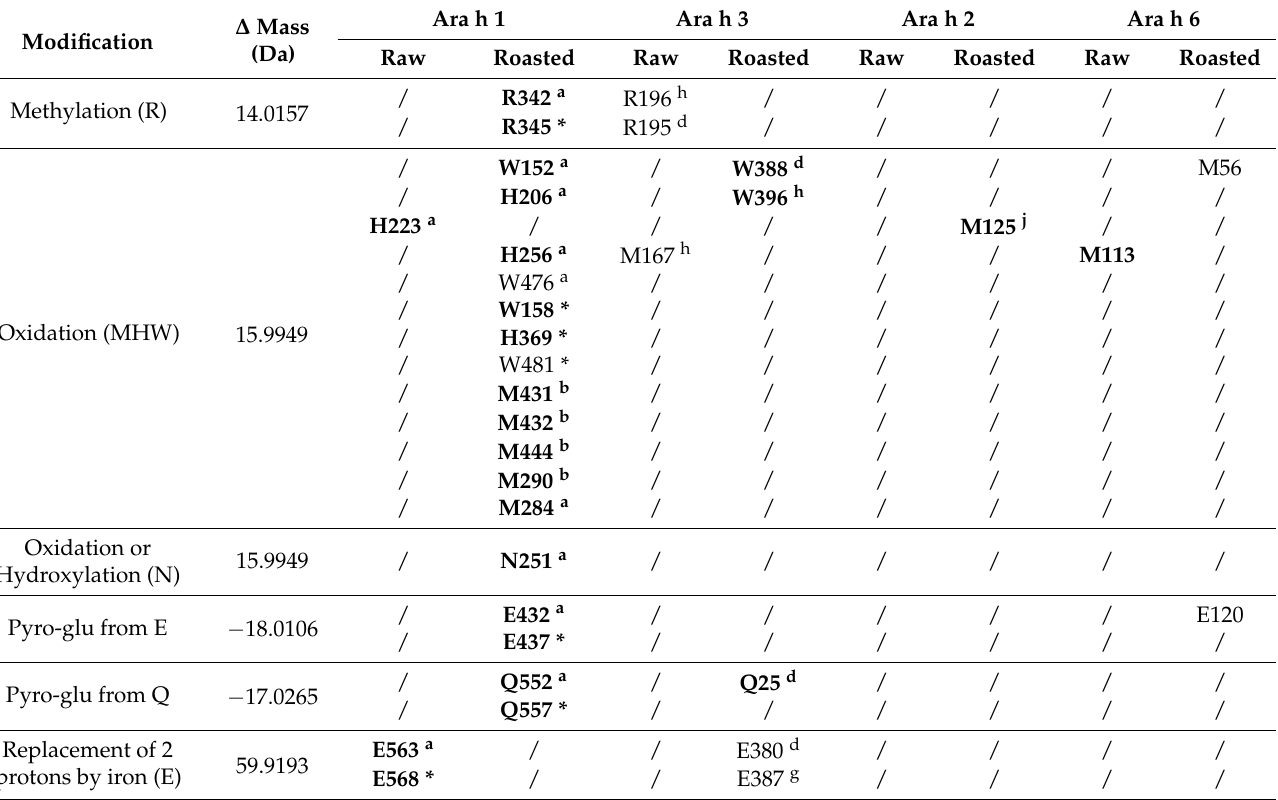
Amino acid residues that are a part of known linear epitopes are designated with bolded characters. Letters in the superscript represent the most dominant UniProt accession numbers. * Denote additional sites within E05G76 allergen isoform with the difference in PTM site between raw and roasted variant, not observed in P43237 Ara h 1 allergen isoform or primary sequence homologous sites with a different outcome in modification presence/absence in respect to P43237 allergen